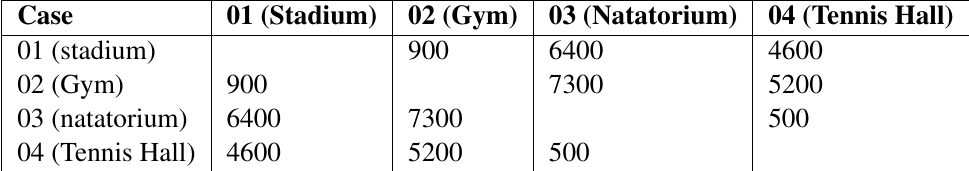
Table 1 Educlidean Distance of Stadiums in Sports